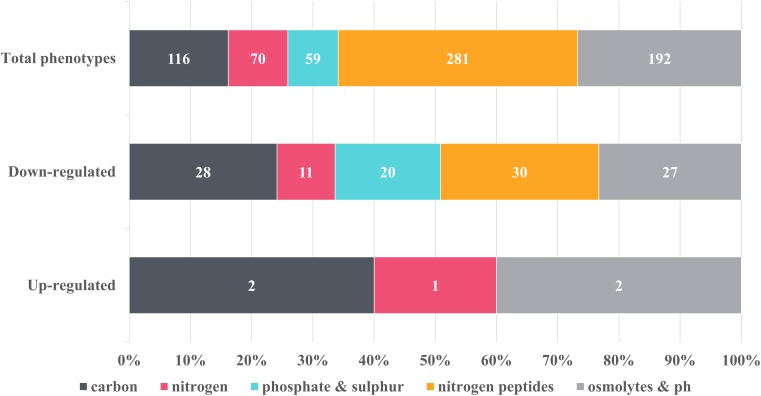
Overview of the metabolic changes detected in NMP-treated K. pneumoniae MGH 78578 as observed in the phenotypic microarray platform. Phenotypes were grouped into classes and the number of representatives contained within each class was indicated on the graph. Control phenotypes were assessed in the presence of DMSO, the solvent used to solubilize NMP. Raw data was analyzed using DuctApe software (v 0.17.4) and significant changes were considered for Δ activities lower and higher than –2 and 2 respectively. Five metabolic pathways were considered to be up-regulated in the presence of 250 μg/mL NMP with 116 being down-regulated.